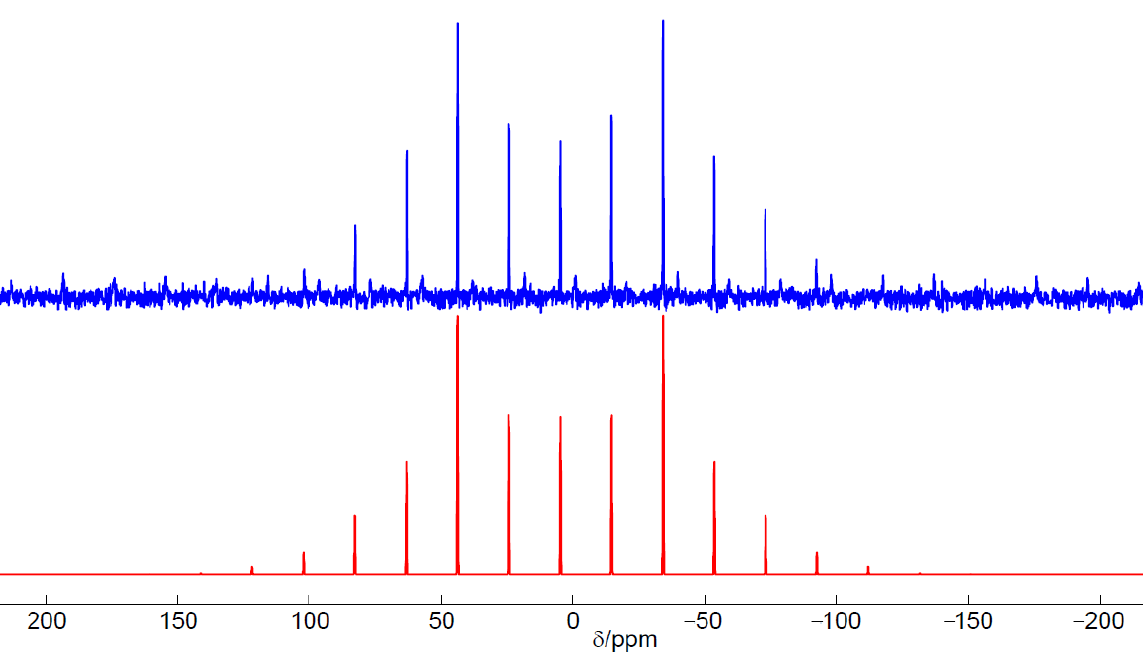
Figure 6. 2 H-NMR spectrum of the deuteride sample from the hydrogenation experiment in the autoclave (k) C12A7:D (blue) together with the fitted spectrum (red).